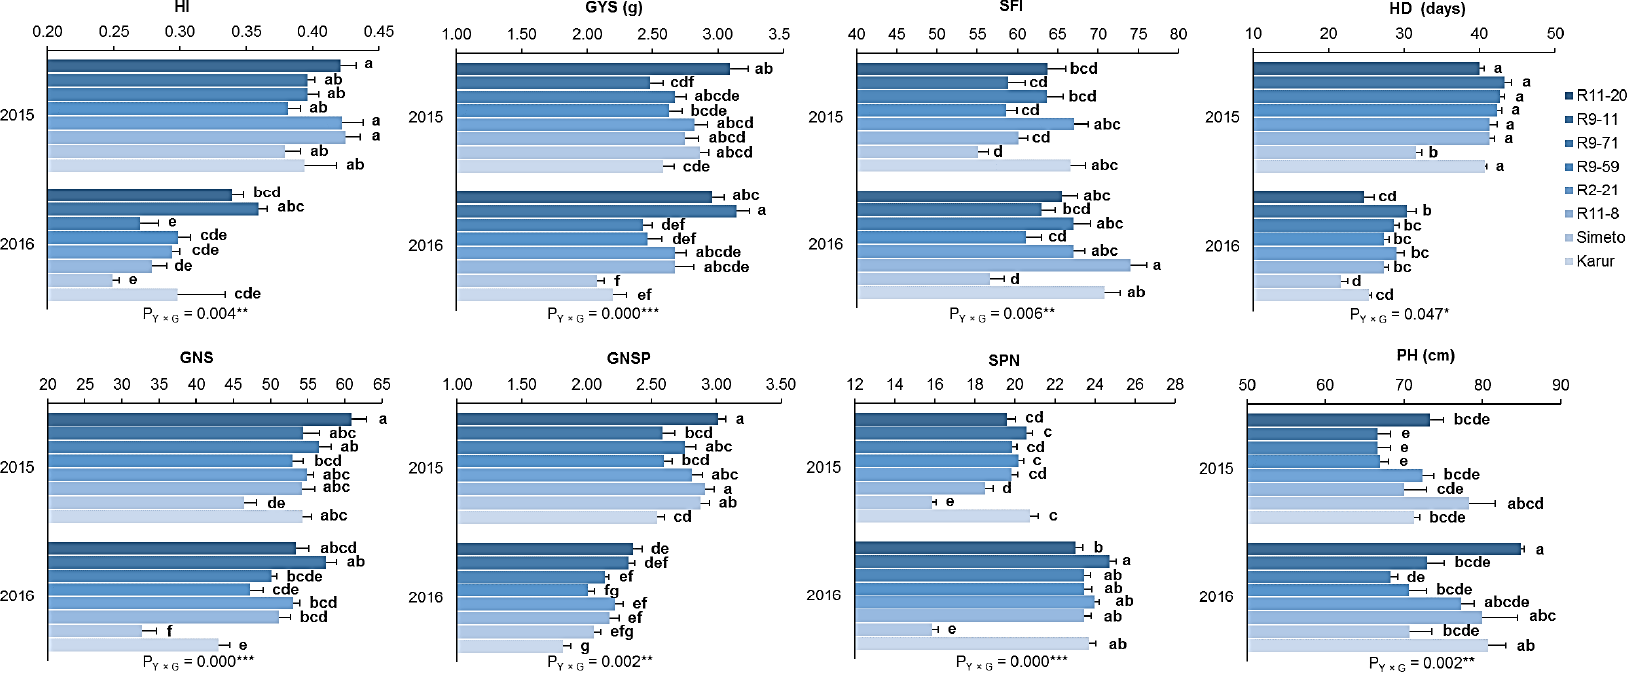
Figure 1. Significant G × Y interactions of yield-related traits recorded across 2015 and 2016 seasons for the eight tested genotypes and analysed by the GLM model (HI, harvest index; GYS, grain yield spike −1 ; SFI, spike fertility index; HD, heading date; GNS, grain number spike −1 ; GNSP, grain number spikelet −1 ; SPN, spikelet number spike −1 ; PH, plant height). Letters for each trait represent ranking of the Tukey test at p < 0.05 level. *, ** and *** indicate significance at p < 0.05, p < 0.01 and p < 0.001 level, respectively.